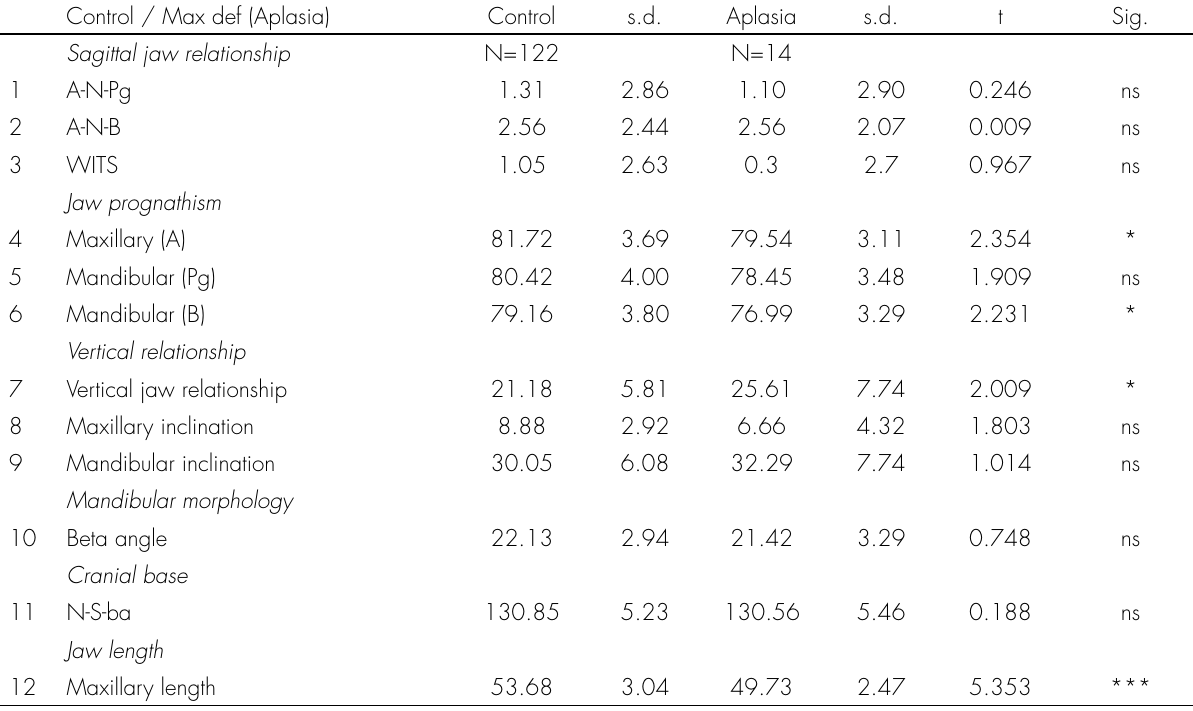
Table IIIa. Comparison between groups of the experimental material and the control material in terms of missing maxillary